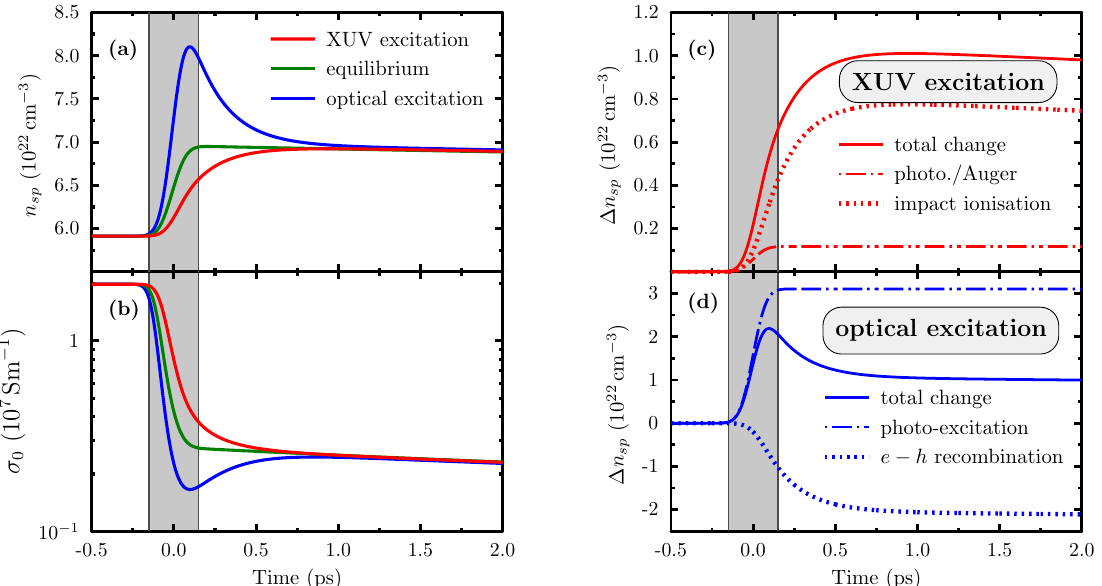
Figure 3. Comparison of excitations with XUV and optical pulses. ( a ) Density response and ( b ) evolution of the DC conductivity of gold after absorption of 13.6 nm (red lines) and 400 nm (blue lines) photons during the time indicated by the shaded area. The green line assuming instant equilibration is independent of the excitation process. All modelling considers electron–phonon coupling according to Ref. 35 . ( c ) Total density change of the 6 sp -band (solid line) due to an excitation with XUV photons, together with the individual contributions due to direct photo-excitation and Auger filling of 4 f -holes (dashed dotted line - both processes yield identical contributions) and impact ionisation of d -electrons (dots). ( d ) Total density variation in the 6 sp -band (solid line) for optical excitation and its contributions via direct photo-absorption (dashed dotted line) and the losses due to filling of holes in the d -band